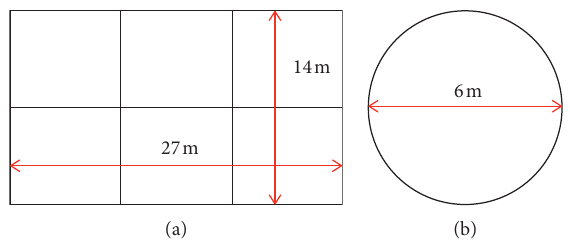
Figure 1: Underground structure model. (a) Station structure. (b) Tunnel structure.